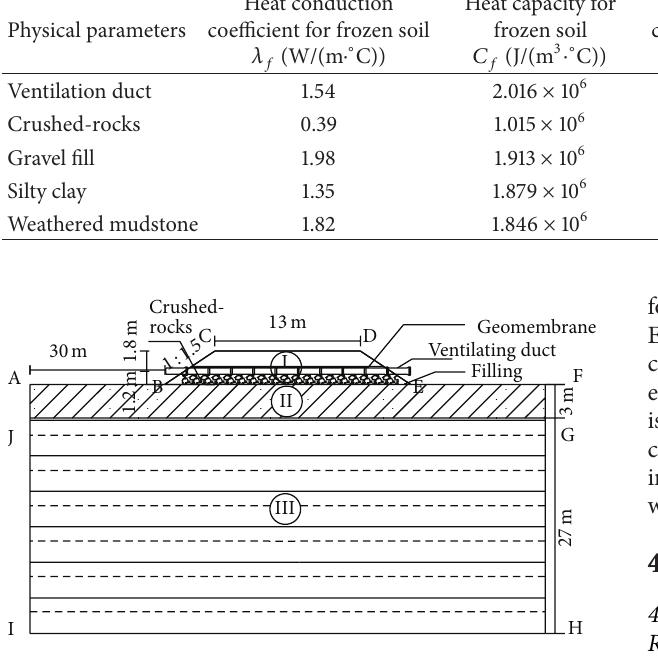
Figure 5: The model of the duct-ventilated and closed crushed- rocks